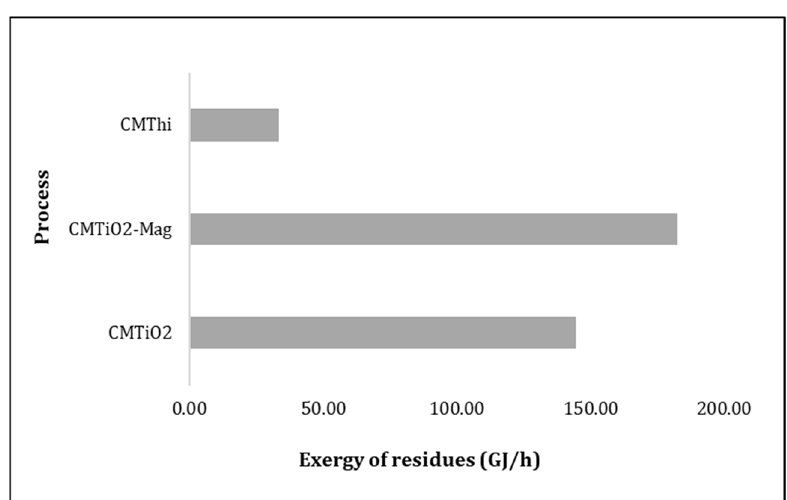
Figure 8. Comparison of exergy of residues for each processing route.